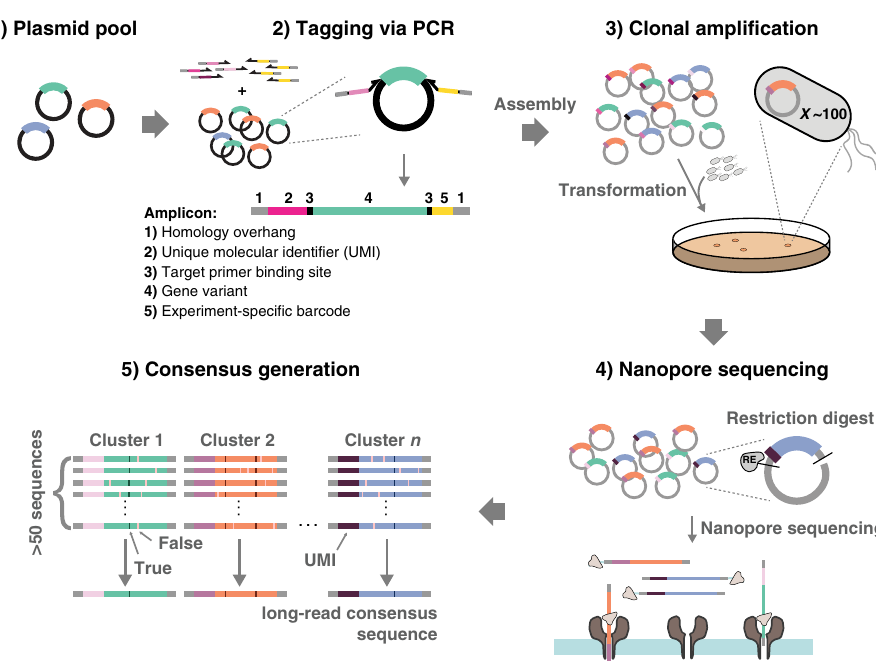
Fig. 1 Sequencing strategy for amplicon libraries with UMI-linked nanopore long reads (UMIC-seq). An amplicon library with similar members, such as a plasmid pool of improved enzyme variants, an immune repertoire or metagenomic 16S sequences (1) is used as input to UMI-tagging and barcoding by PCR (2). The resulting products have unique sequence identi fi ers (UMI) for clustering and barcodes for multiplexing, as well as homology overhangs used for Gibson assembly. Gibson assembly provides plasmids for transformation, which enables the selection of a subset of the library, obtaining selectively ampli fi ed UMI-variant combinations (3). This sample is then subjected to nanopore sequencing (4) and data processing via barcode- and UMI-based clustering followed by variant calling, yielding the desired variant sequences with high accuracy